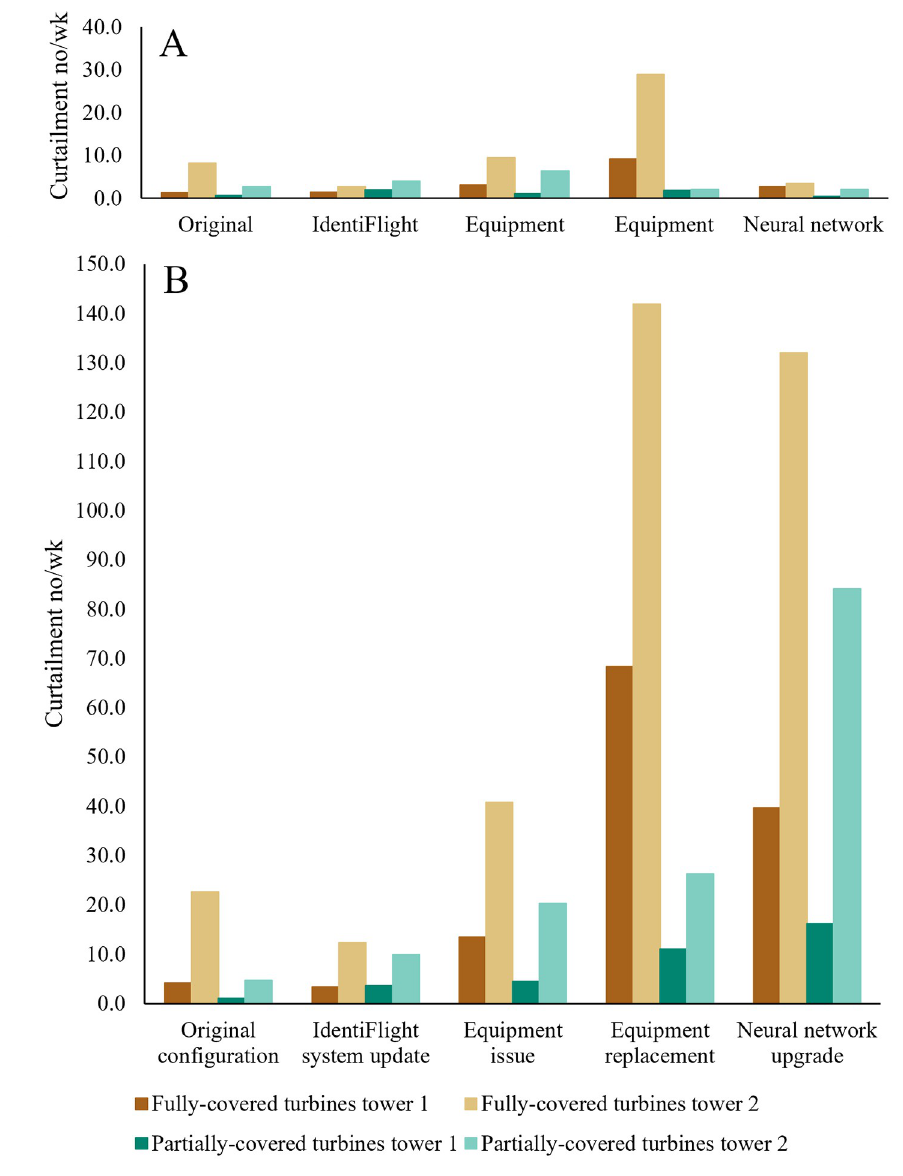
Fig 4. Rates of virtual curtailments (no/wk) issued by the IdentiFlight system for targets A) that it correctly identified as eagles and B) that it misidentified as eagles at the Manzana Wind Power Project, California, USA over time periods in which the system changed June 2018 to June